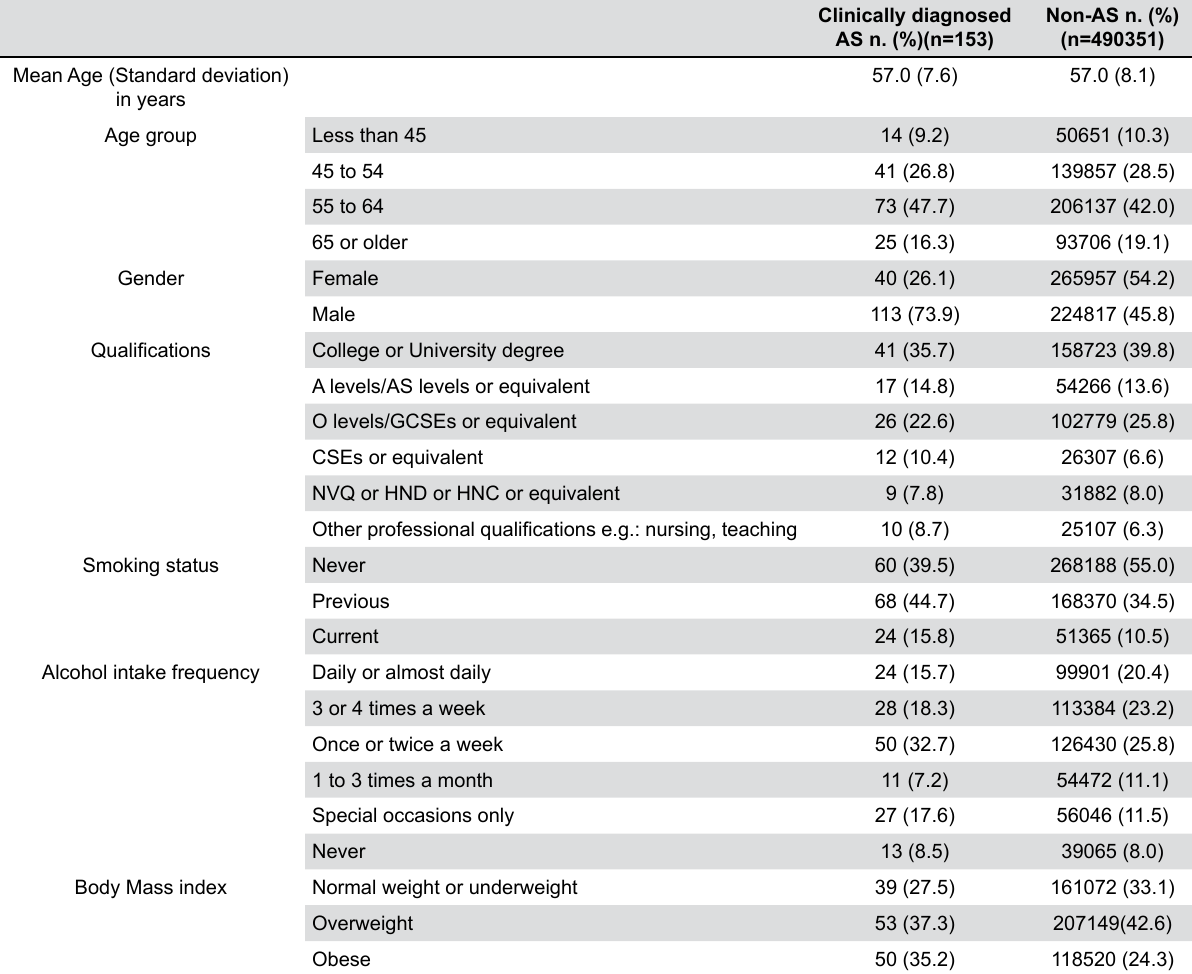
Table 4- Socioeconomic description of the clinically diagnosed AS cases and control groups, excluding clinically diagnosed rheumatoid arthritis (RA), self-reported AS in the control group only, and self-reported RA